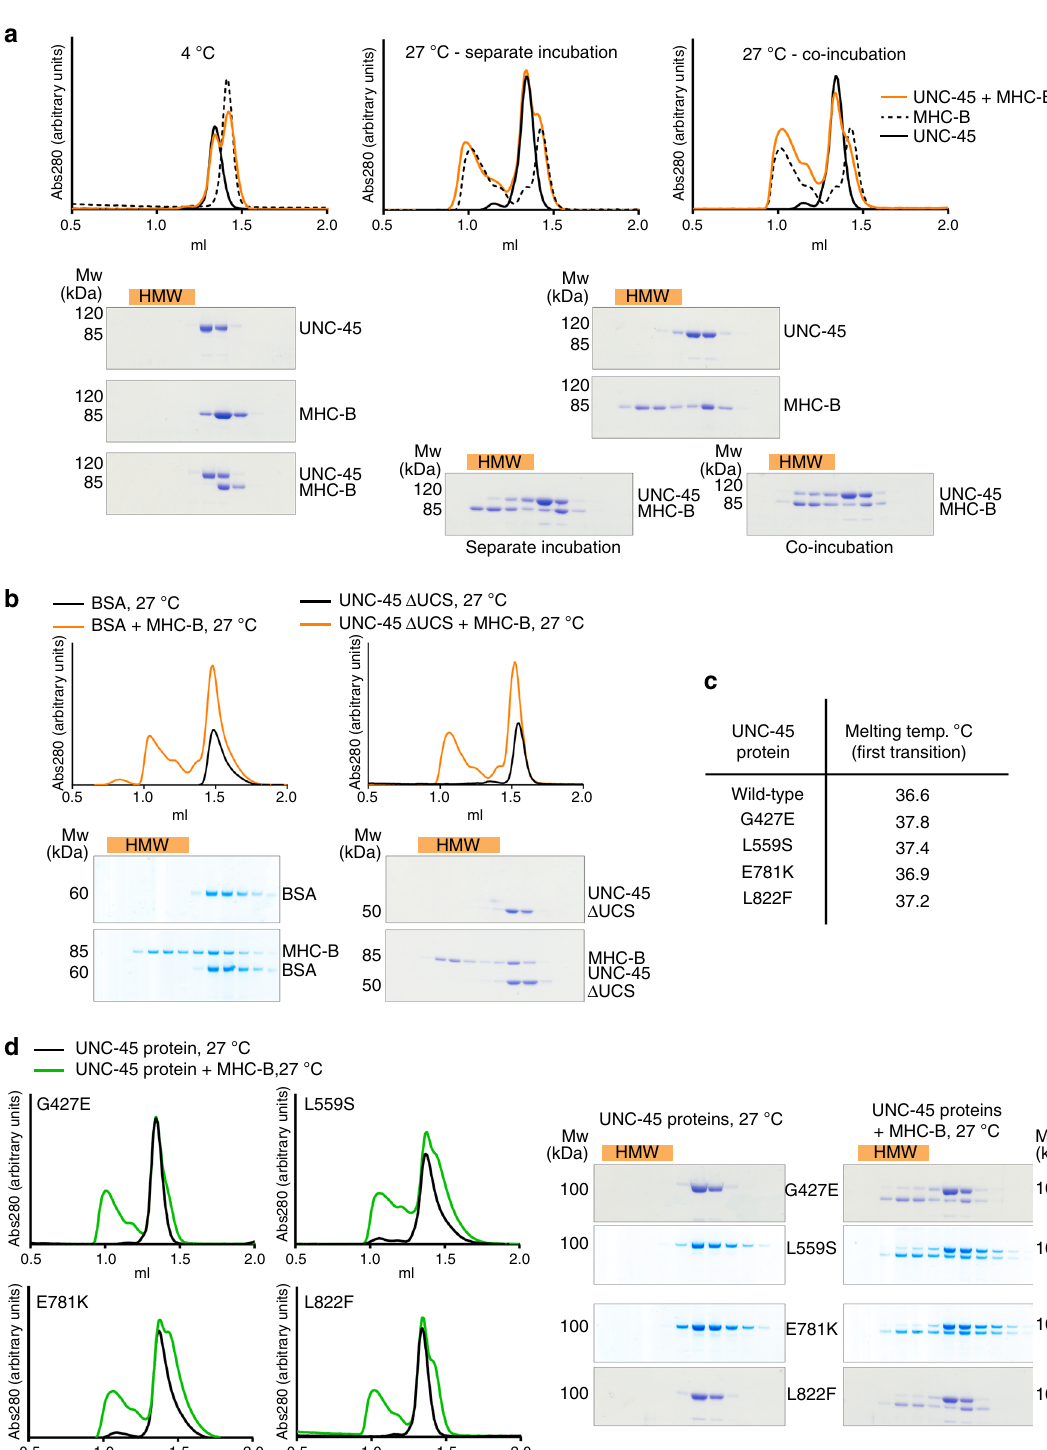
Fig. 4 Interaction of UNC-45 proteins and myosin in vitro. a Analytical SEC and SDS-PAGE analysis of UNC-45 and myosin incubated together at 4 °C or at 27 °C and incubated separately at 27 °C and mixed before the SEC run. Misfolded myosin and bound UNC-45 proteins elute earlier from the SEC column, indicated as high molecular weight fractions (HMW, orange bar). b Controls for interaction studies shown in a . BSA or UNC-45 Δ UCS were incubated with myosin at 27 °C. c Melting temperature as determined by CD spectroscopy for the indicated UNC-45 proteins. d Same analysis as in a for the indicated UNC-45 ts -mutants and myosin, incubated together at 27